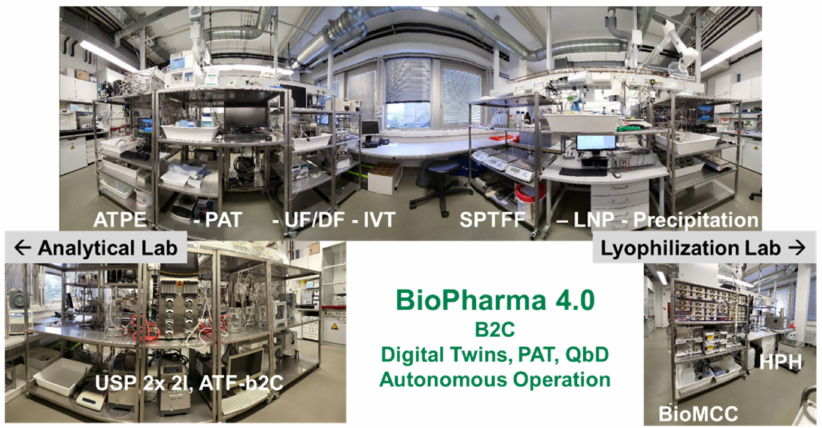
Figure 4. Biomanufacturing development